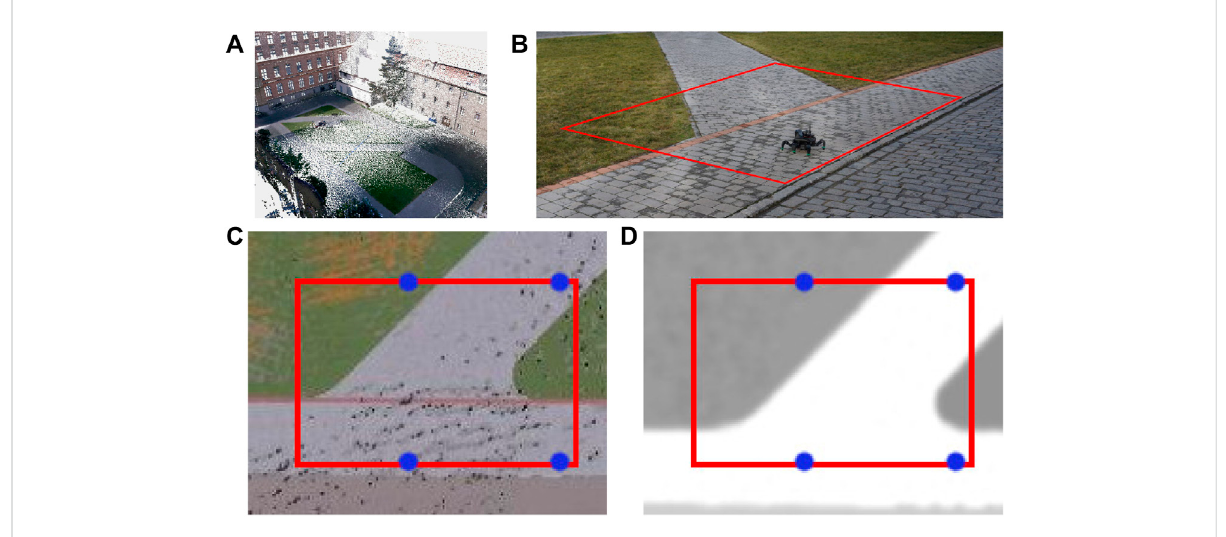
FIGURE 6 (A) 3D scan of the university campus at Charles Square in Prague, (B) section of the courtyard, and the respective simulated environment (C) colorand (D) relativetraversability(lightareaseasiertotraverse).Theredboundingboxrepresentstheareawheretherobotshouldexplore.Theblue points are the points to be visited by the robot in the fi rst test